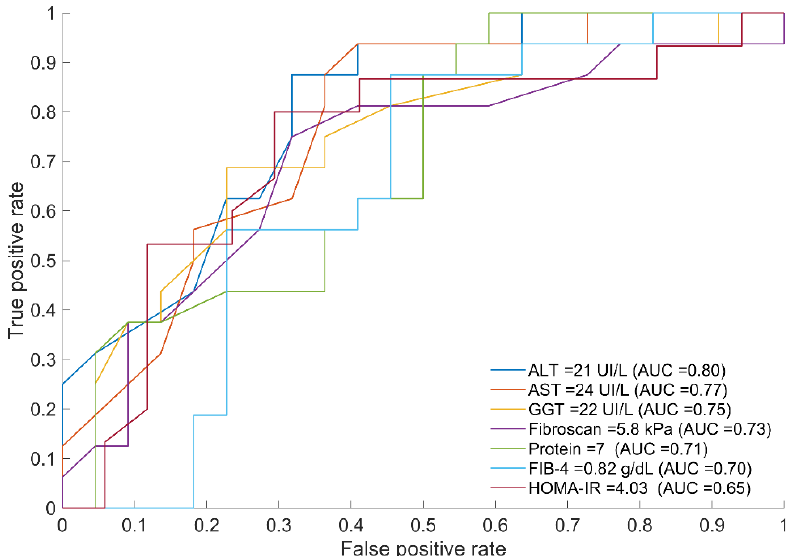
mIS) were obtained for the variables significantly different between groups (Figure 2).